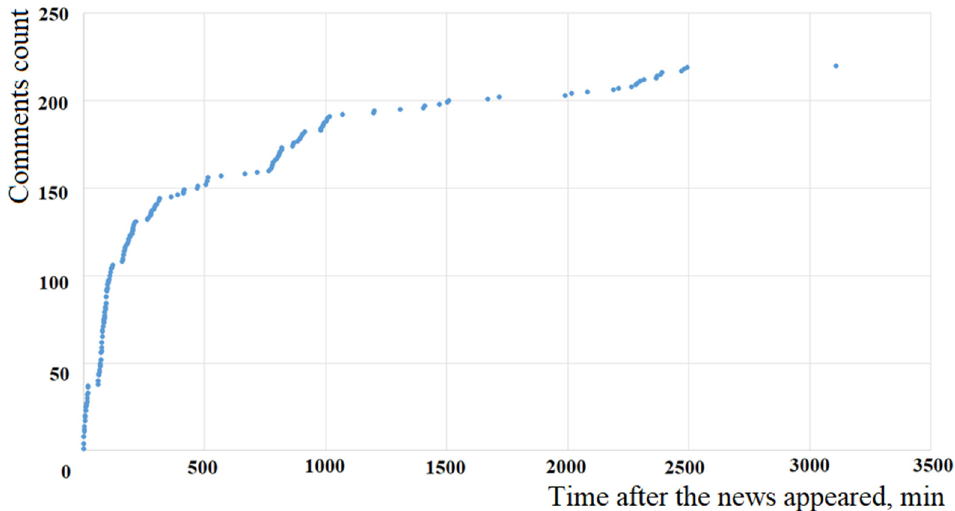
After removing the time gaps, the dynamics take the form shown in Figure 8.